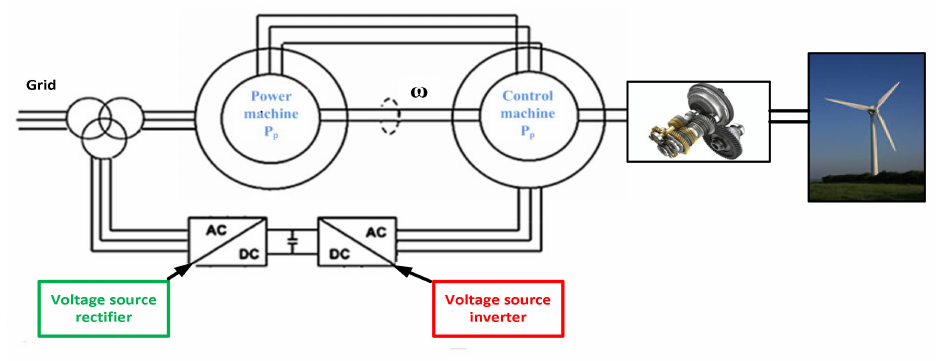
Figure 1. BDFTSIG arrangement for wind energy conversion systems